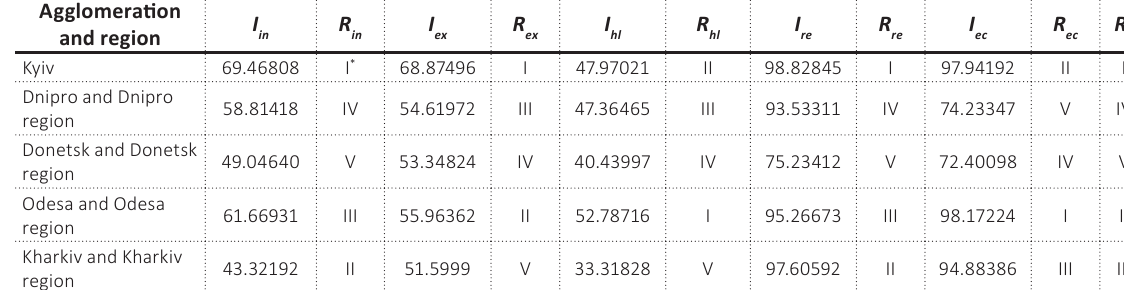
Table 3. Relative indicators of social, environmental and economic assessment of wellness and